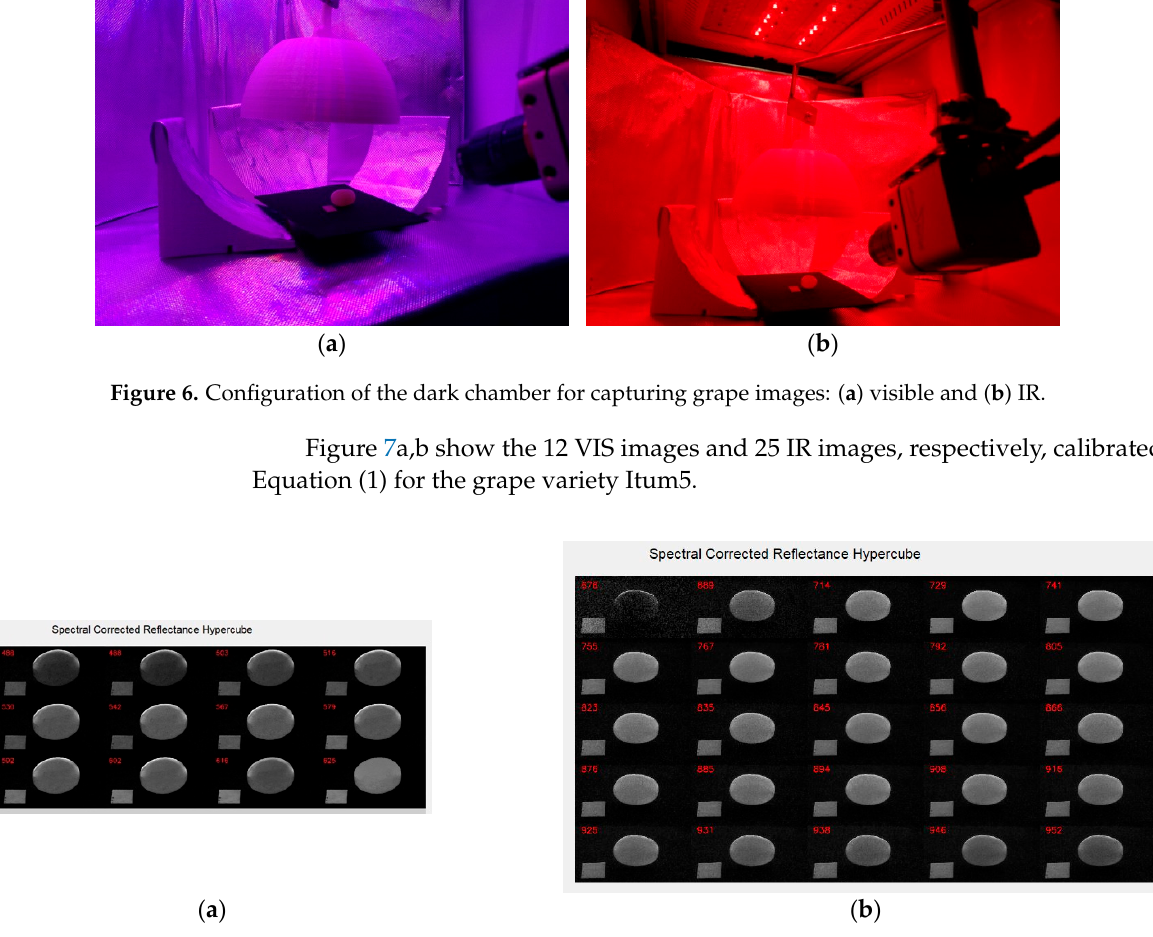
Figure 7. ( a ) 12 bands of grape variety Itum5 obtained in the visible spectrum and ( b ) 25 bands of grape variety Itum5 obtained in the IR spectrum.